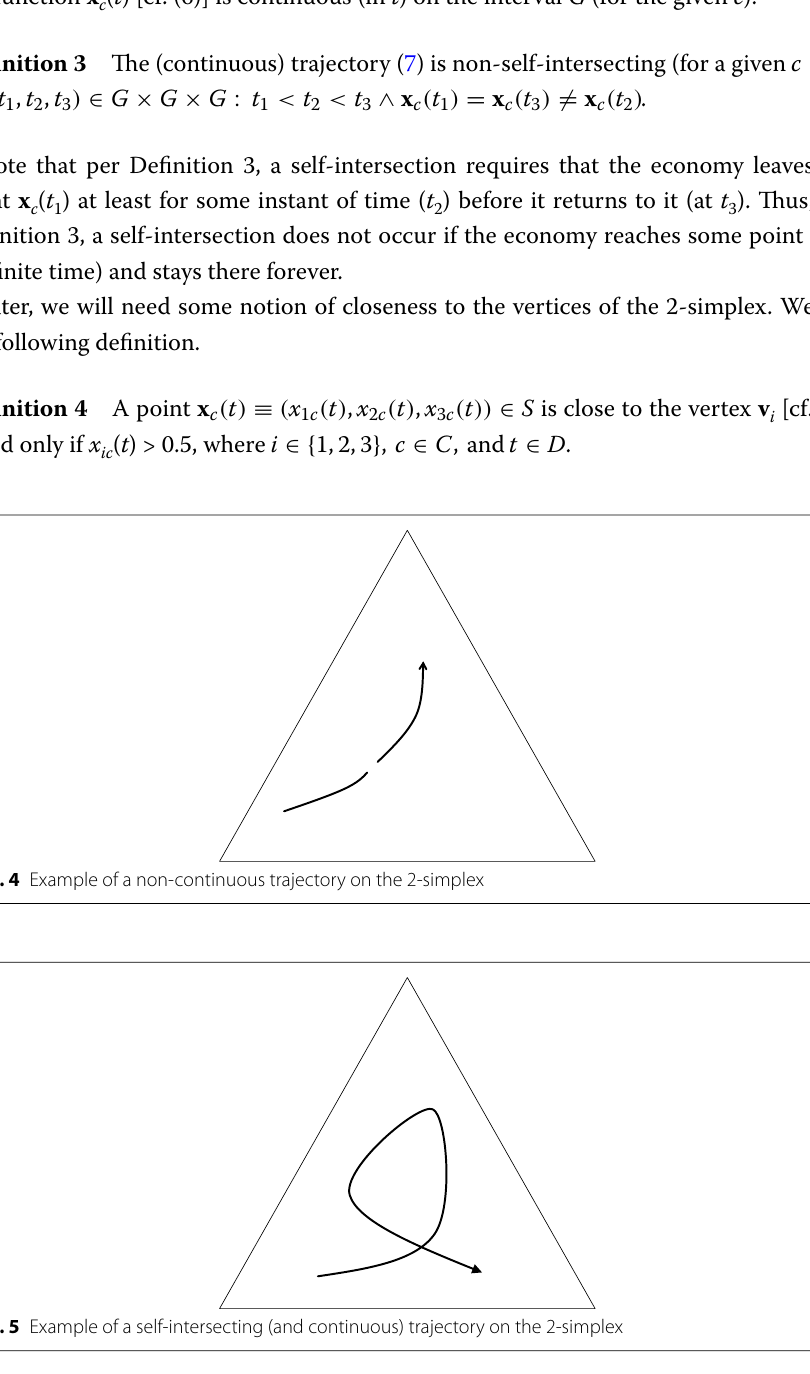
Figs. 4 and 5 depict examples of non-continuous and self-intersecting trajectories, respectively.